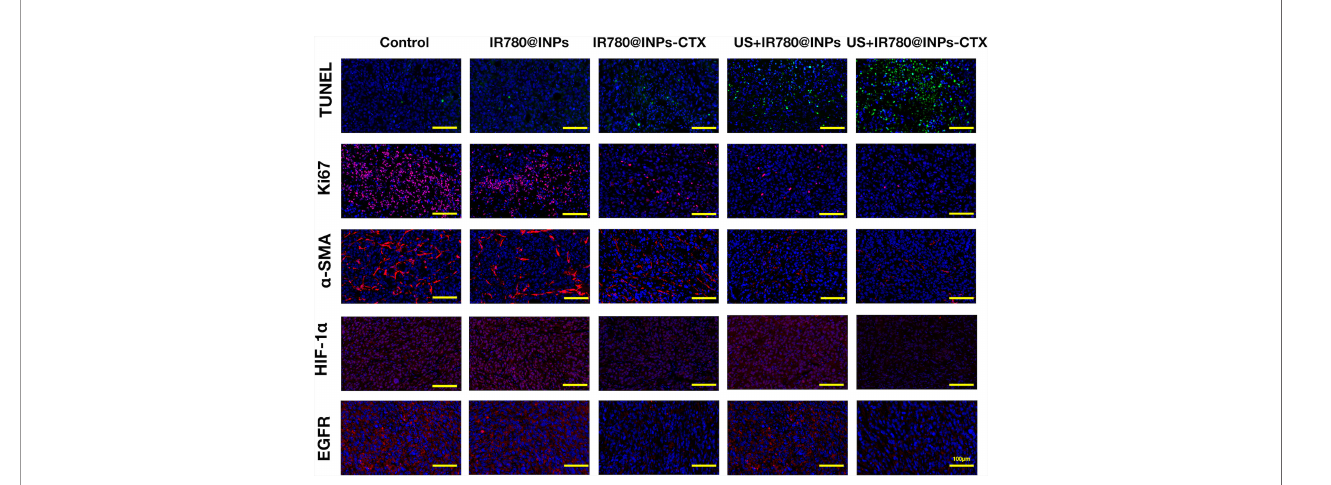
FIGURE 7 | Ki-67, a -SMA, EGFR, HIF-1 a and TUNEL immuno fl uorescence staining detection pictures of tumor sections in each group (the scale bar is 200 m